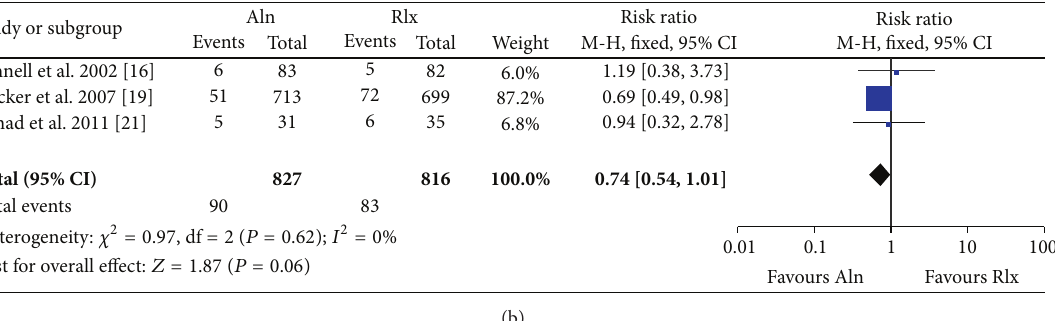
Figure 3: Relative risk of discontinuations due to adverse events, upper gastrointestinal disorders related to treatment, diarrhea events, venous thrombosis events, vasomotor events, and vasodilatation events for postmenopausal women assigned to alendronate compared with